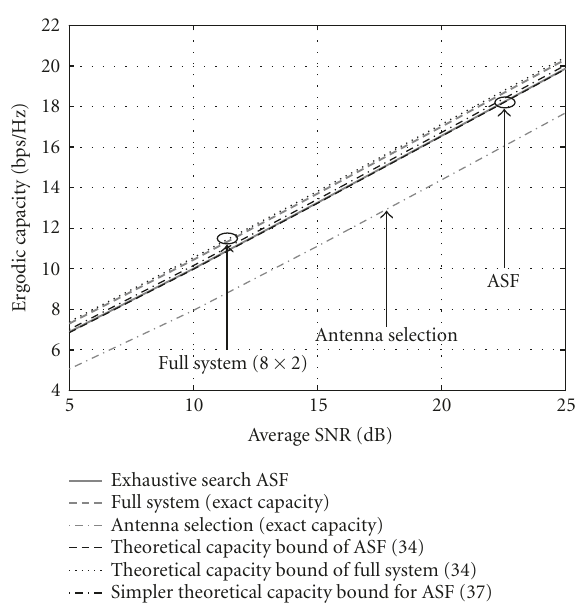
Figure 3: Ergodic capacity bounds for ASF and capacity of exhaus- tive search ASF when M R = 8, M T = 2, and K = 8 variable gain- linear amplifiers and phase shifters are available at the receiver (4 antenna elements in each subarray). Results are compared to an er- godic capacity bound and exact ergodic capacity of the full